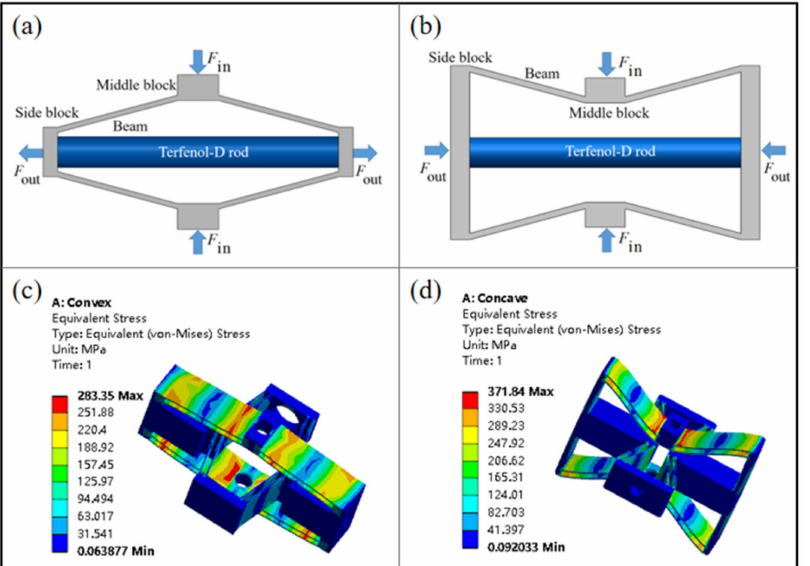
Figure 2. Structural and stress analysis of different frames. ( a ) Convex frame structure diagram; ( b ) Concave frame structure diagram; ( c ) double-stage convex frame stress diagram; ( d ) double-stage concave frame stress